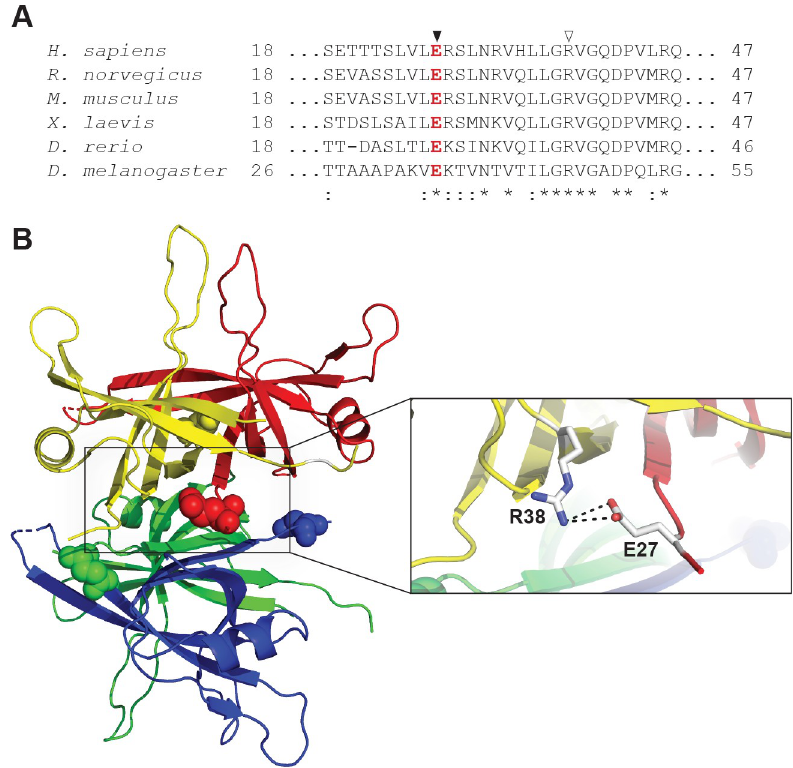
Fig 4. Glutamate 27 of SSBP1 is conserved among higher eukaryotes and may participate in a salt bridge at dimer interfaces. A. Amino acid sequence alignment of SSBP1 from six species shows that E27 ( ▼ ) is conserved among higher eukaryotes ( � , invariant conserved amino acids; :, highly conserved sites). B. E27 residues are highlighted as ball models on a ribbon diagram of the structure of the SSBP1 tetramer (PDB 3ULL). The inset shows that E27 in each monomer may participate in a salt bridge with R38 ( 5 in A ) from its respective adjacent monomer. The distances shown for the interactions in this potential salt bridge are 3.4 Å (top) and 3.1 Å